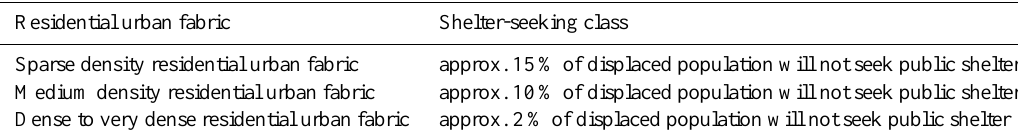
Table 2. Shelter-seeking class definition.